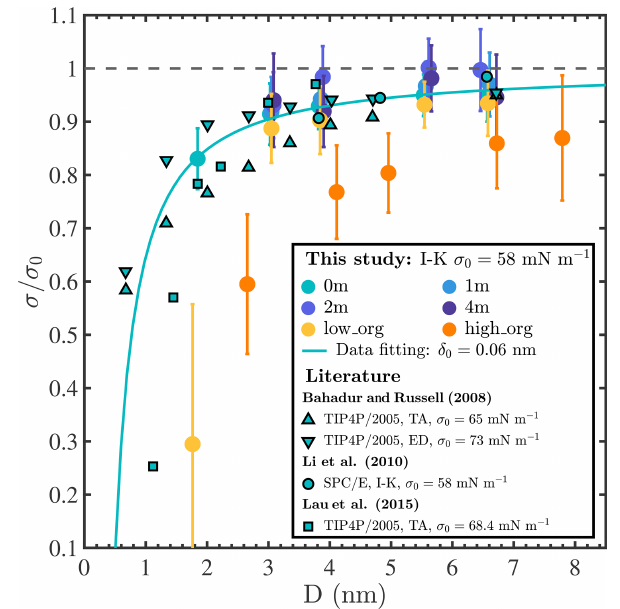
Figure 4. Normalized surface tension ( σ/σ 0 ) of droplets as a func- tion of droplet diameter ( D ). Colored circles show results ob- tained in this study using the SPC/E water model and the Irving– Kirkwood (I–K) pressure tensor method; symbols with black edges show previous MD simulation results obtained for pure-water droplets at ambient temperature using the TIP4P/2005 or SPC/E water models and the test-area (TA), energy difference (ED), or Irving–Kirkwood (I–K) methods (Bahadur and Russell, 2008; Li et al., 2010; Lau et al., 2015); the light-blue solid line shows a fit of our 0m surface tension data to the second-order Helfrich expansion, yielding the Tolman length δ 0 = 0 .